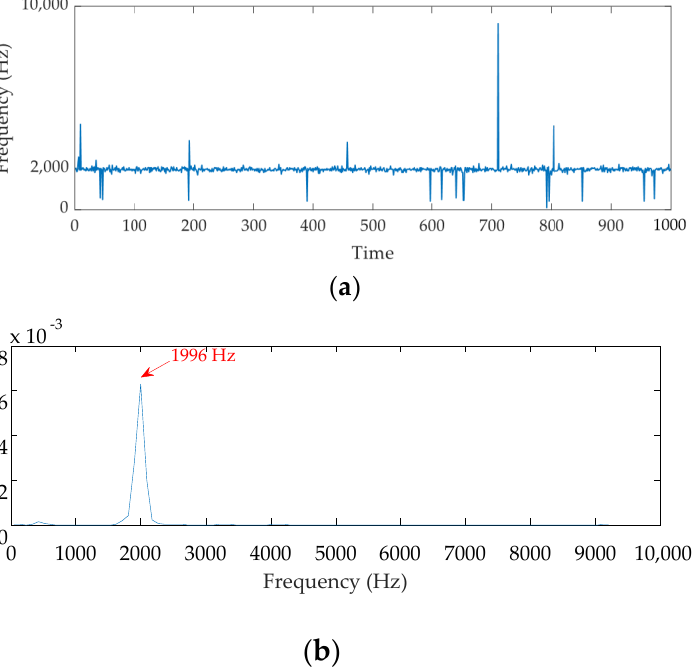
f and ( b ) the probability c